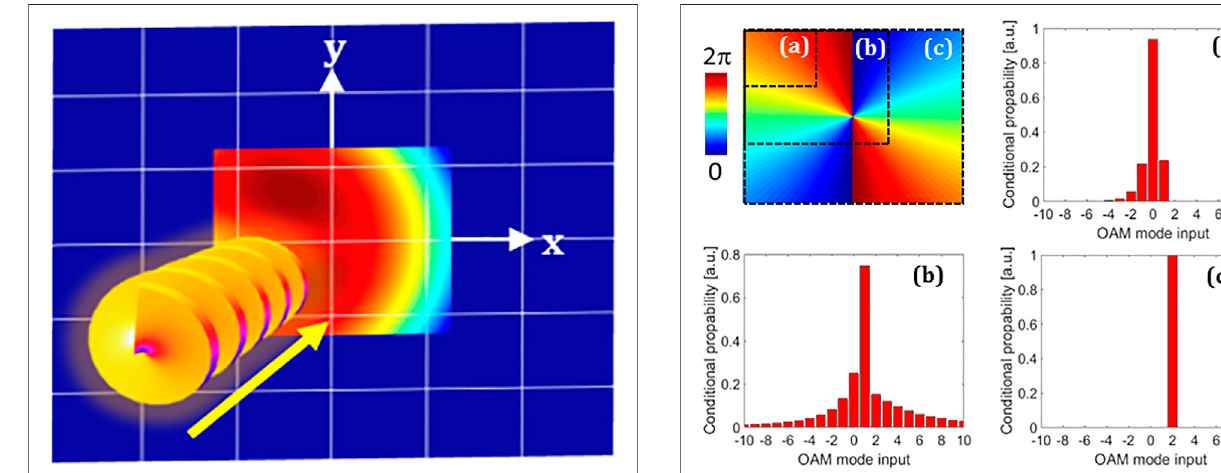
FIGURE 6 | OAM attained spectrum, in the case of l = 2, when phase analysisiscarriedoutfordifferentareasandlocationsinthephasedistribution. The pure state is screened, as modal spanning is formed.